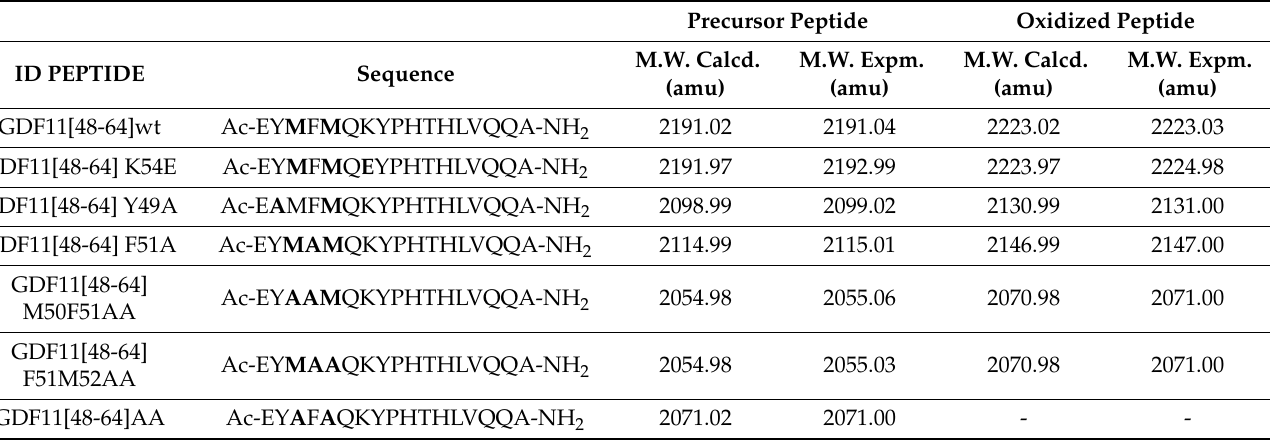
Table 1. Set of GDF11-related peptides containing methionine residues used as substrate models to evaluate the APEH endoprotease activity. Peptide sequences and their calculated (calcd.) and experimental (expm.) MWs, as estimated by LC-ESI-TOF mass analyses, are reported. Mass values were obtained from the deconvoluted mass spectra. Methionines (M) and residues replaced in the mutated peptides are highlighted in